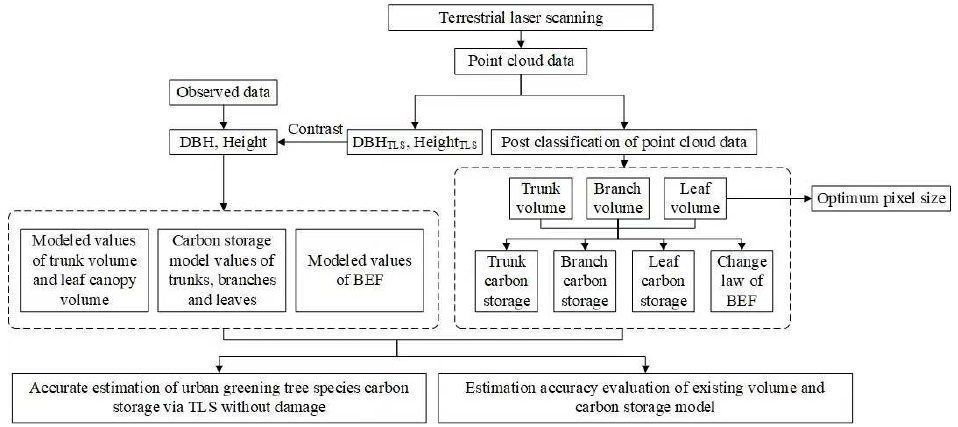
Figure 2. Conceptual diagram of the research approach.